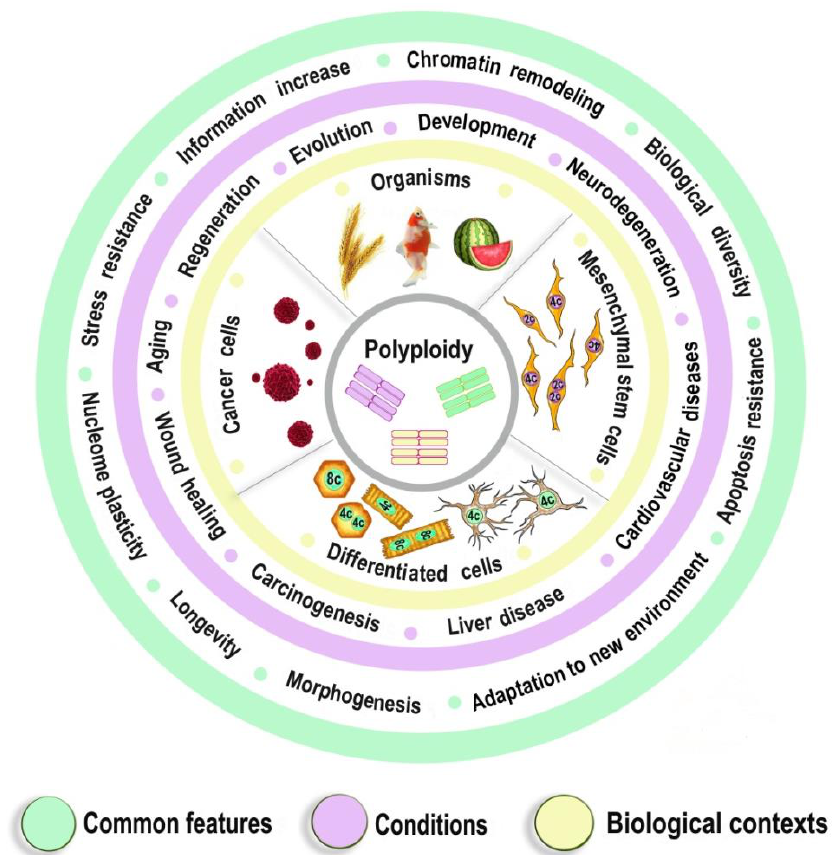
Figure 5. The most important Common features of polyploidy found at various physiological conditions and in different biological contexts.